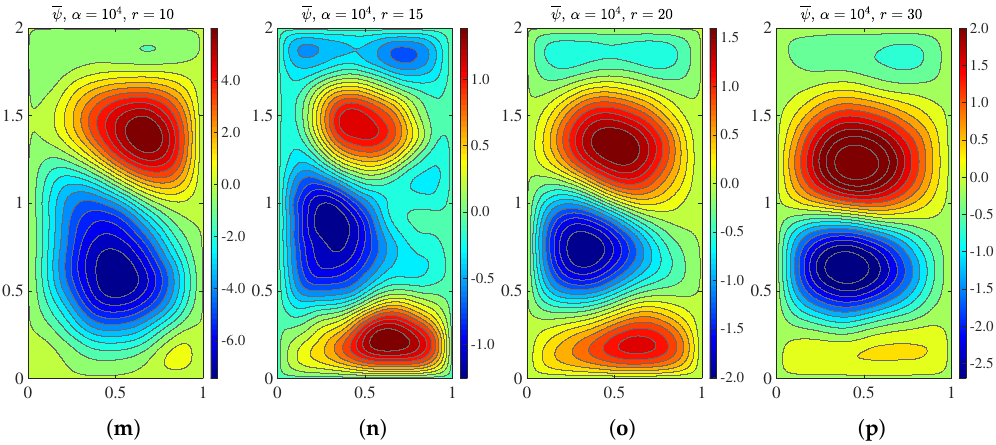
Figure 5. Eulerian investigation, predictive regime: Mean streamfunction from E-ROM (plots ( a – d )), λ -ROM (plots ( e – h )) α -ROM with α = 1 (plots ( i – l )), and α = 10 4 (plots ( m – p )), for r = 10 (plots ( a , e , i , m )), r = 15 (plots ( b , f , j , n )), r = 20 (plots ( c , g , k , o )), and r = 30 (plots ( d , h , l , p )).